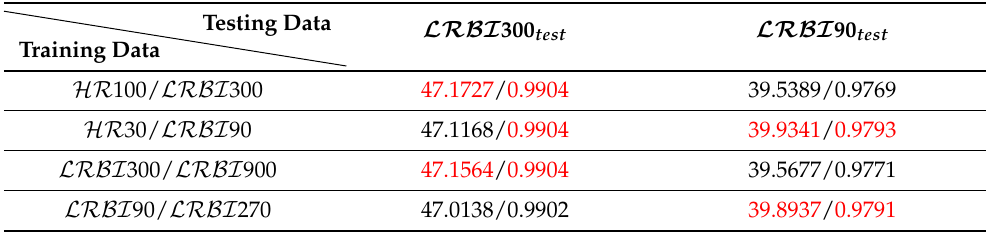
Table 8. Results of resolution adaptability (PSNR(dB)/SSIM). The best results under each data situation are marked in